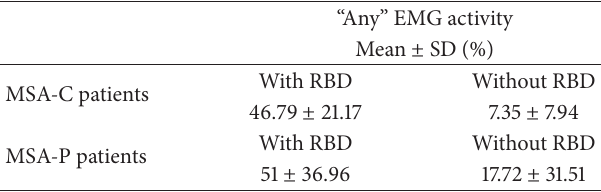
Table3:Thepercentageof “any”EMGactivityinMSApatientswith RBD.